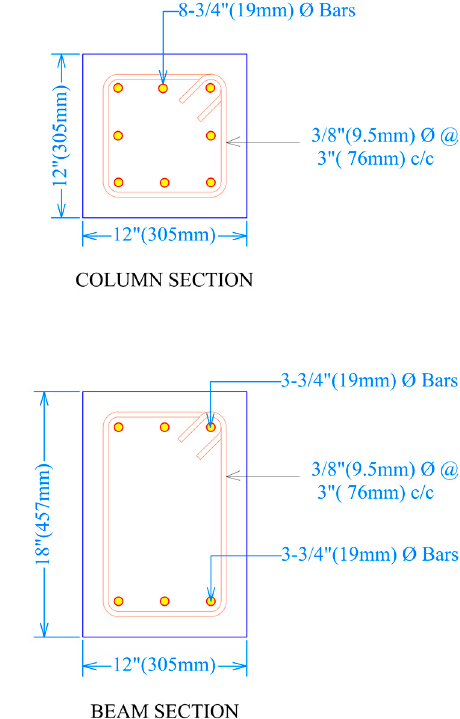
Figure 6. Geometric and reinforcement details of the beam/column members and panel.